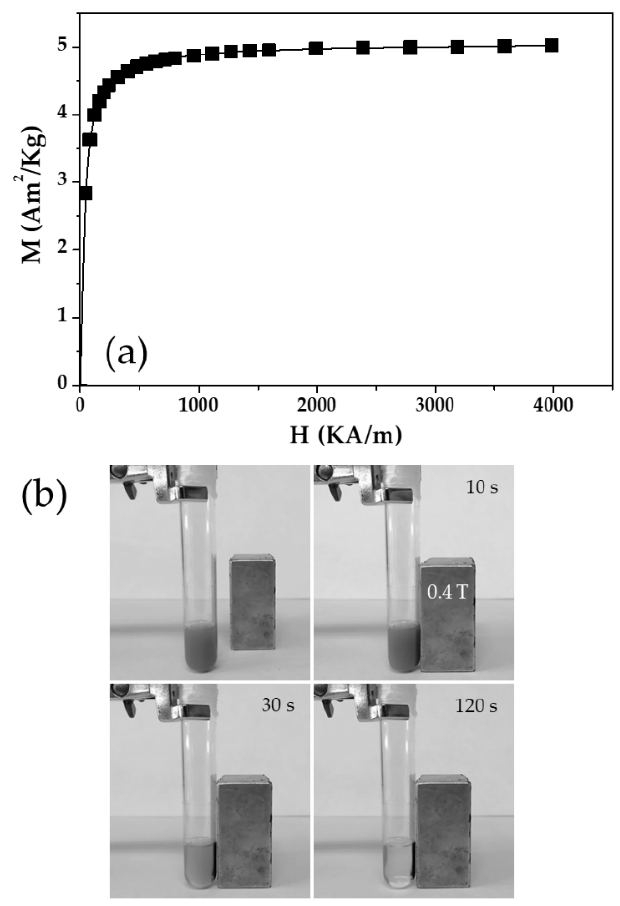
Figure 5. ( a ) First magnetization curve of the (core/shell)/shell NPs. ( b ) Visual observation of the colloid (0.1%, w/v ) under the influence of 0.4 T permanent magnet, located close to the right lateral flat surface of the glass vial.